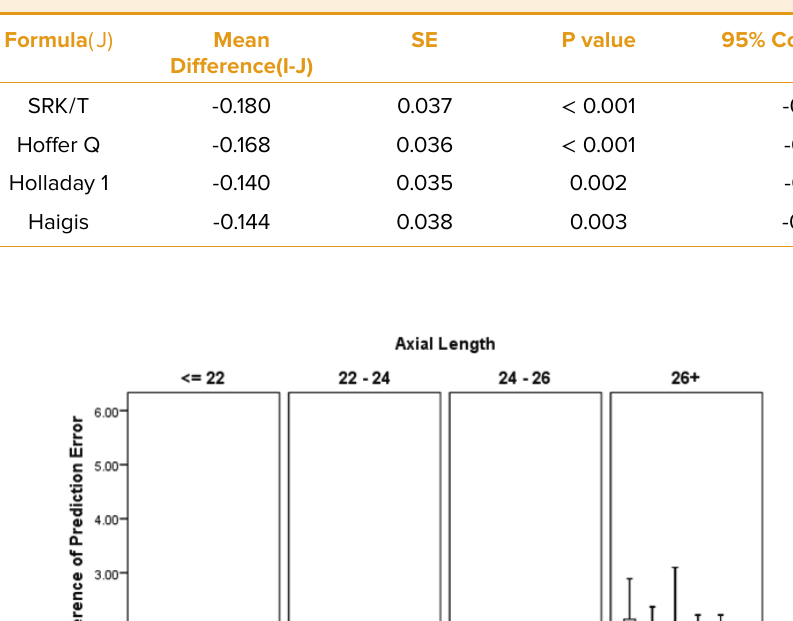
Table 3. Pairwise Comparison of absolute prediction error between Okulix and other formulas